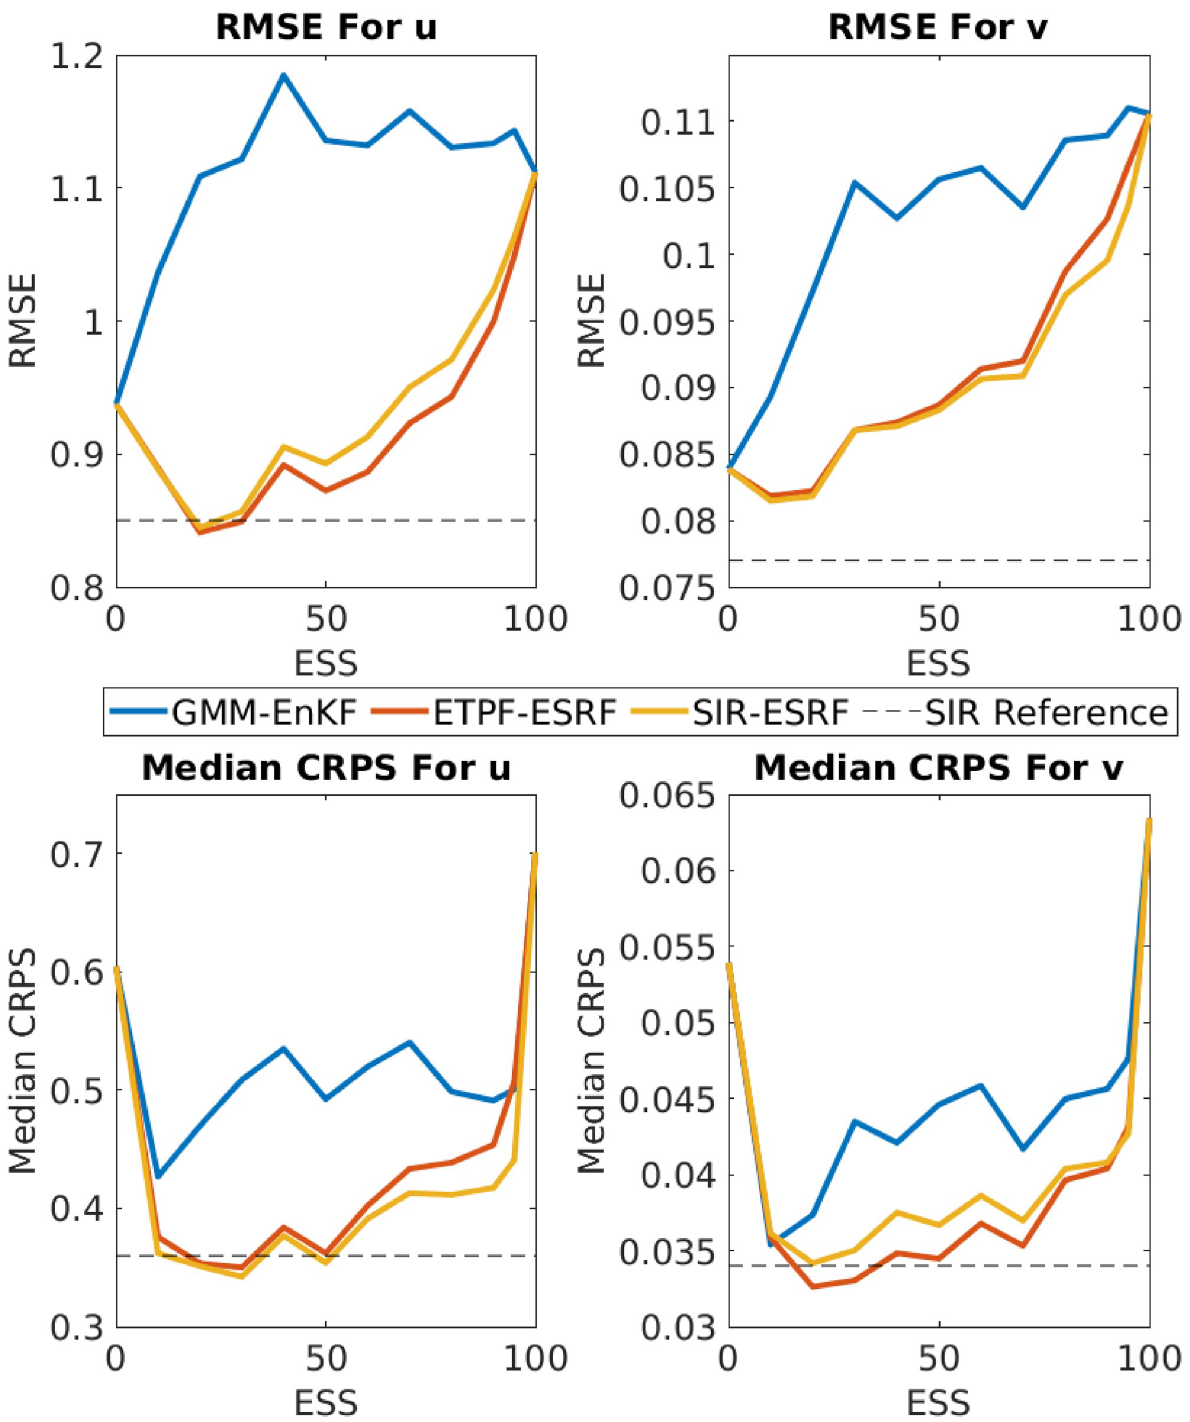
Fig 2. Filter performance over 1,000 trials as a function of ESS threshold. Top row: RMSE. Bottom row: Median CRPS. Left column: Results for the U variable. Right column: Results for the V variable. The ETPF results are shown in the plots at ESS = 0 even though the ESS for ETPF is typically around 4.4. The ESRF results are shown in the plots at ESS = 100. The dashed line in each panel shows the performance of an SIR particle filter with 10 4 particles.